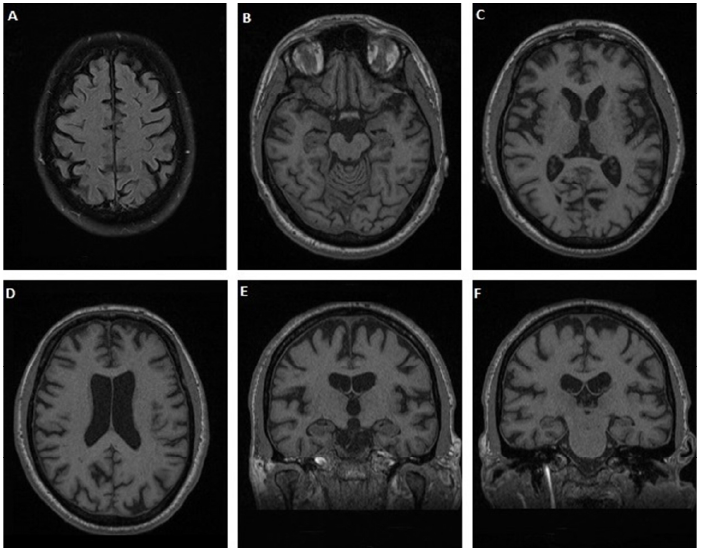
Figure 6. Brain MRI of case 6. Axial ( A – D ) and coronal ( E , F ) T1 images showing significant cortical atrophy in frontal, parietal and temporal lobes.